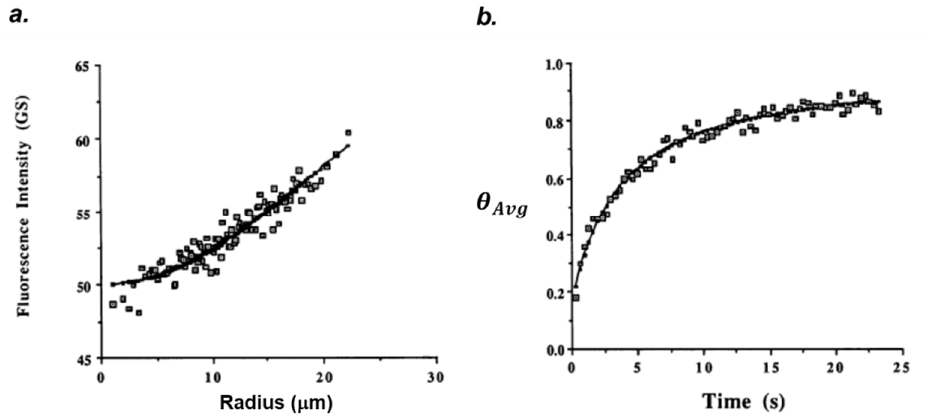
Figure 3. Photobleaching recovery for ( a ) fluorescence intensity ( I TA ∝ C TA ) against r plotted from t = 0, immediately after photobleaching is fitted with Equation (22) for determining the value of R 0 and I TB . ( b ) D eff is determined by fitting the dimensionless average fluorescence intensity data θ Avg against time by fitting to Equation (31) and β is determined by measuring D in nonbinding system. Reprinted with permission from [95]. Copyright 1991, Elsevier.